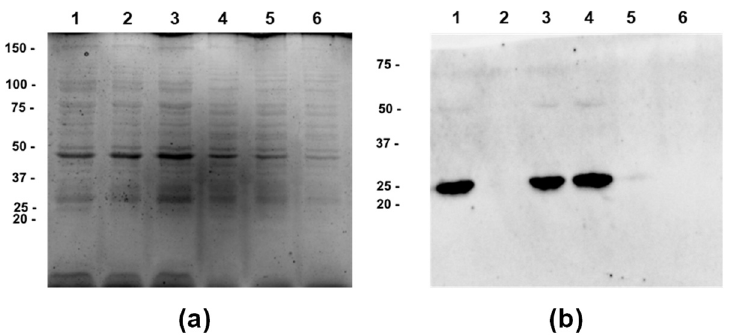
Figure 5. The characterization of the MVs from the GFP-tagged P. zantedeschiae 9M strain. ( a ) SDS- PAGE analysis of the MVs harvested from three independent cultures of the wild-type P. zantedeschiae 9M (bands 1–3) and the GFP-tagged strain (bands 4–6). Proteins were visualised by a Coomassie Brilliant Blue staining. The GFP protein size is about 27 kDa. Size standards are indicated on the left side of the image (kDa). ( b ) Western blot analysis with anti-GFP monoclonal antibodies of the GFP-tagged P. zantedeschiae 9M strain (bands 1, 3, 4) and the wild-type strain (bands 2, 5, 6). Size standards are indicated on the left side of the image (kDa).